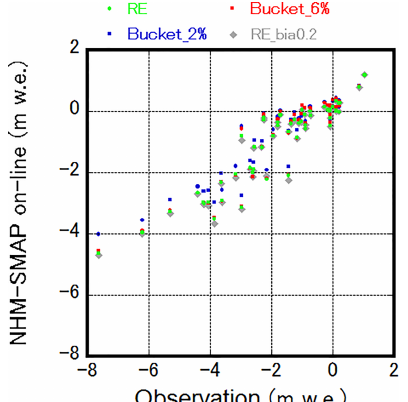
Figure 8. Scatter plot of observed and simulated SMBs during the study period. Observation data are from stake measurements com- piled by PROMICE and ice core measurements from SIGMA-D and SE Dome. RE indicates the default setting for vertical water move- ment in snow and firn based on the Richards equation; Bucket_6% and Bucket_2% are alternative settings based on simple bucket schemes with irreducible water contents of 6 and 2% of the pore volume; RE_bia0.2 is another alternative setting, where bare ice albedo is set to 0.2, while the other configuration is the same as RE.